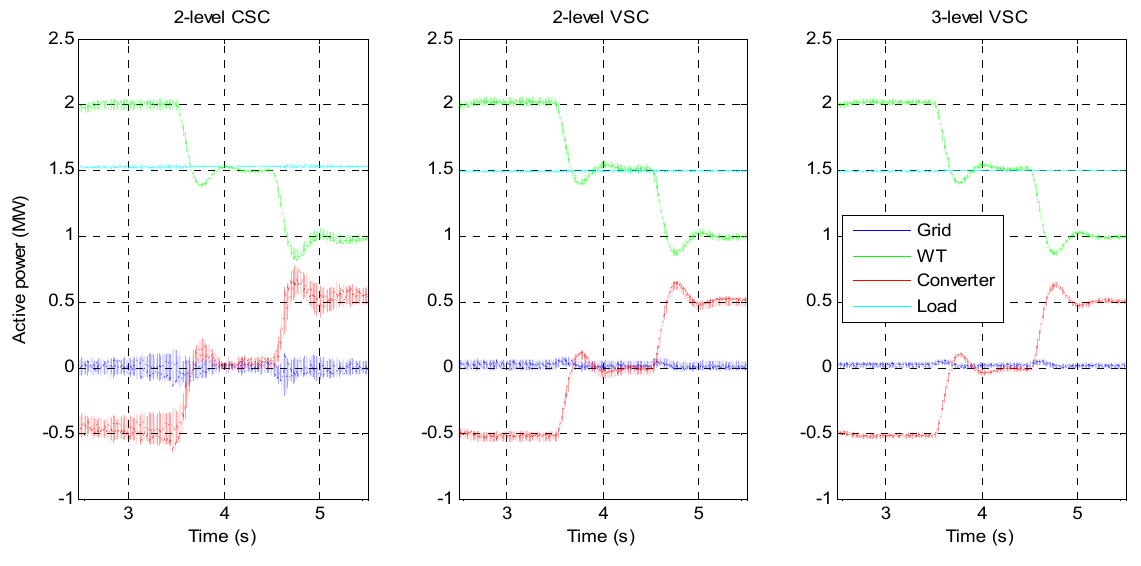
Figure 16. Grid, WT, converter and load active power in each